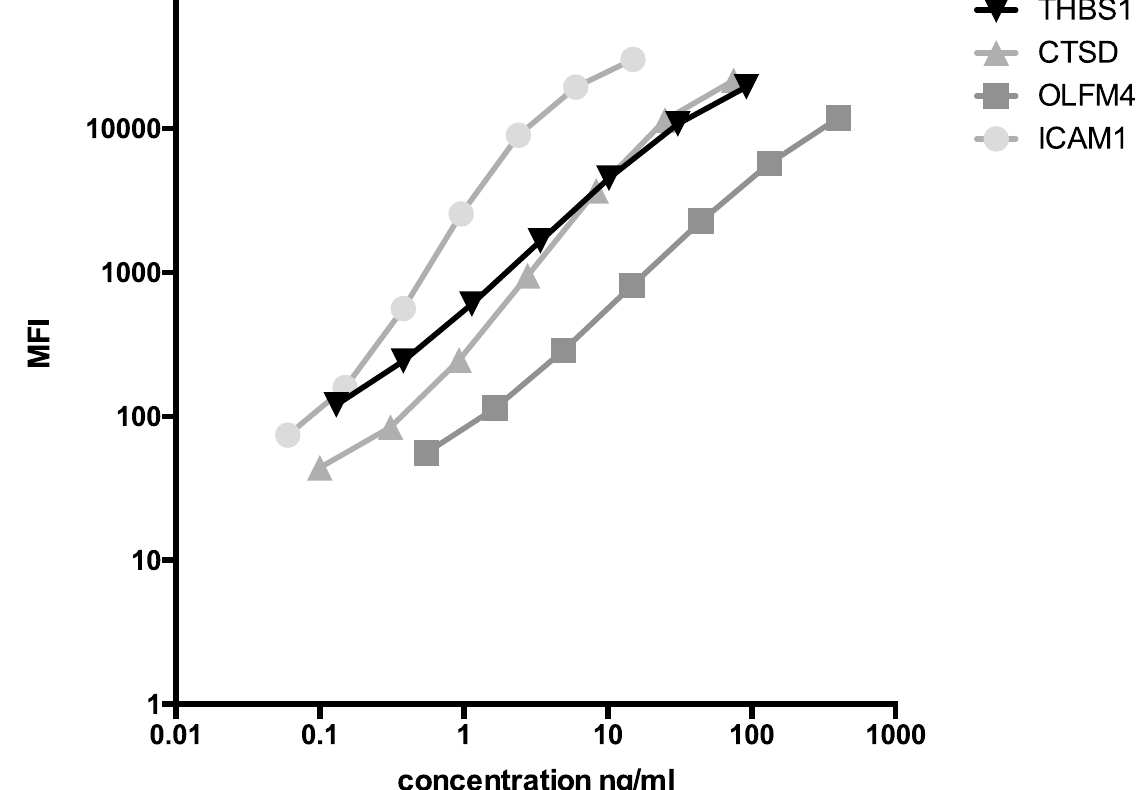
Fig 1. Assaycalibration curves. Representative calibration curves for the CTSD, ICAM1, OLFM4, and THBS1 assays.